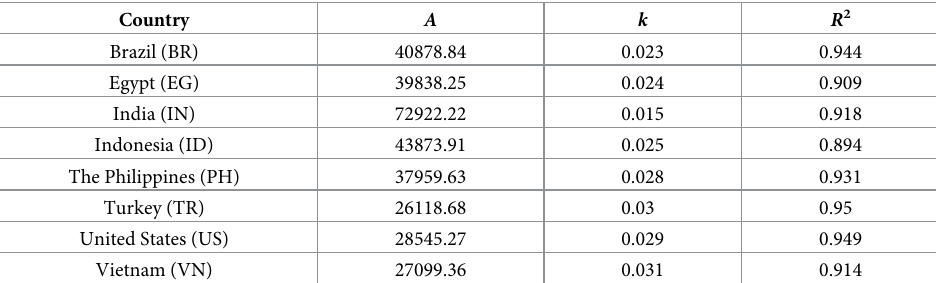
Table 2. Exponential regression results of each country’s data. Here, p < 0.001 for all parameters. See T1 in S1 File for the full set of regression